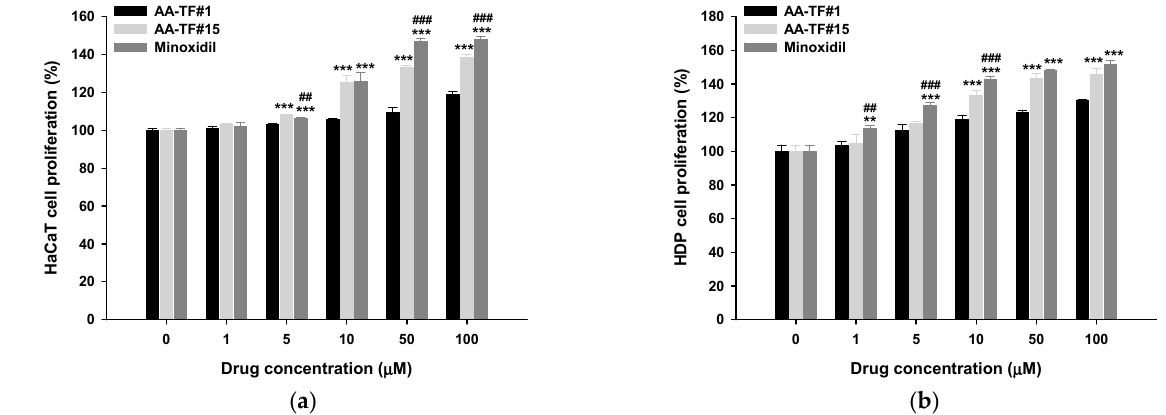
Figure 3. Relative cell proliferation of ( a ) keratinocytes (HaCaT) and ( b ) human follicle dermal papilla (HDP) cells after treatment with atraric acid (AA) topical formulations (AA–TF#1 and AA–TF#15) or minoxidil in ethanol (EtOH). Solutions were diluted to drug concentrations of 0, 1, 5, 10, 50, and 100 µM. ** p < 0.01, *** p < 0.001 compared to AA–TF#1; ## p < 0.01, ### p < 0.001 compared to AA–TF#15 at the same drug concentration. Values are represented at mean ± SD ( n = 4 for each group). Cellular proliferation in HDP cells was similar to that of HaCaT cells (Figure